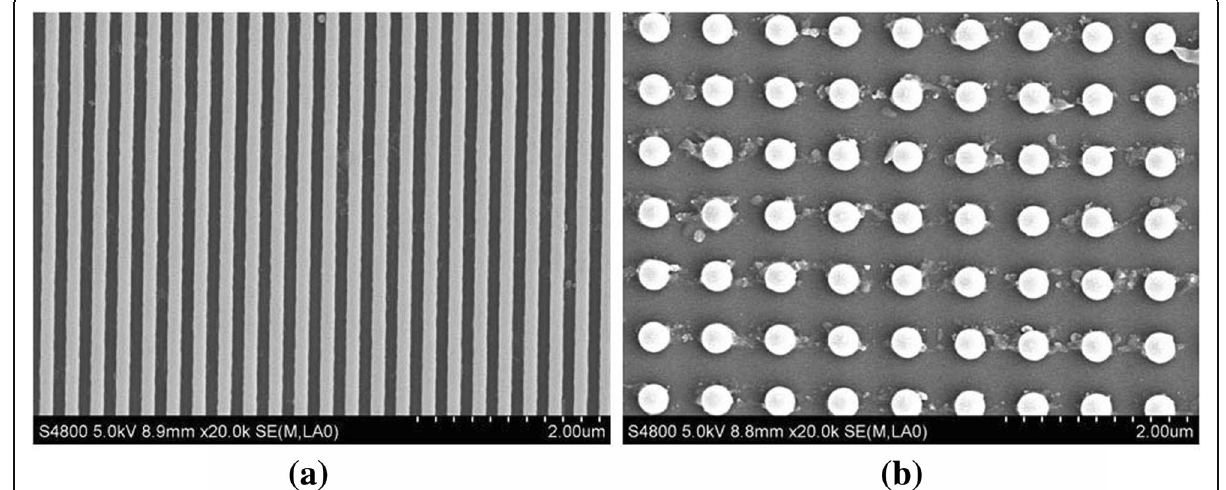
Fig. 1 SEM images of two kinds of surface nanostructures. A grating ( a ) and a nanopillar array ( b ) are